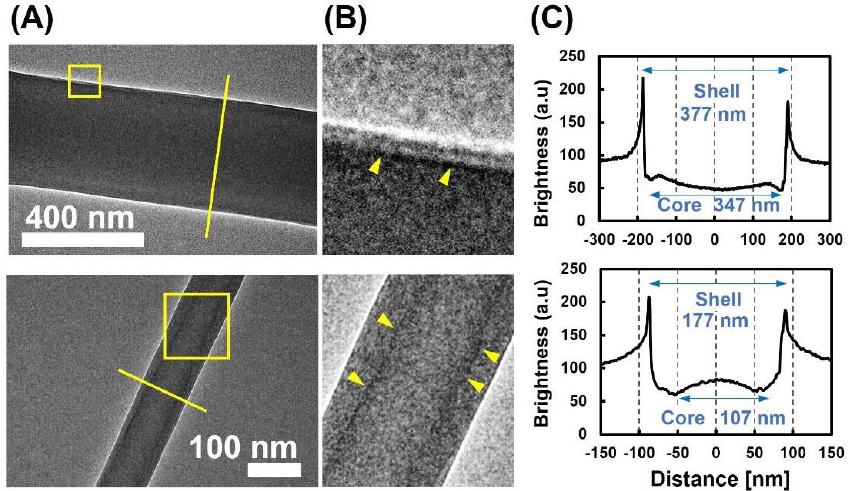
Figure 2. ( A , B ) Two representative TEM images of CA/PVA + PA NF with different diameters. Arrowheads represent the interface between the core and the shell. ( C ) The brightness distribution of the cross-section of the fiber shows the core-shell